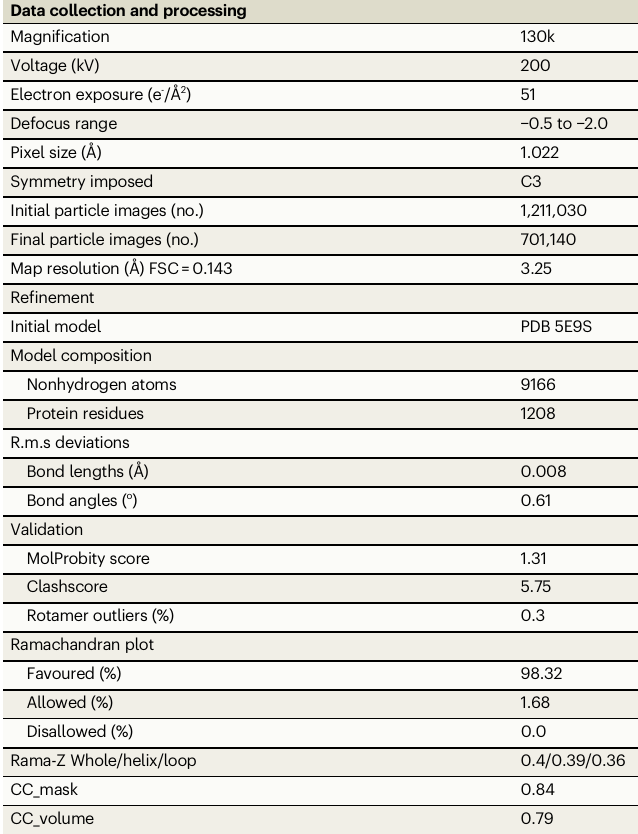
Table 1 | Cryo-EM data collection, re fi nement and validation